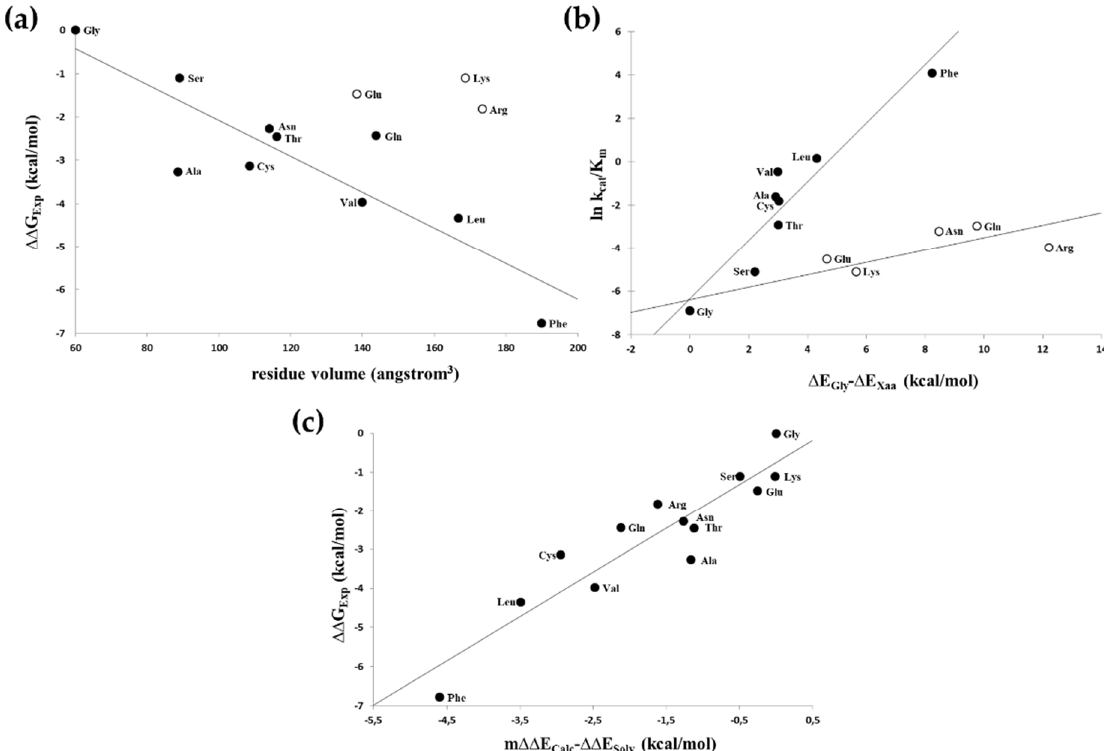
Figure 3. Plotting experimentally determined relative activation energies and calculated S1 (cid:48) -P1 (cid:48) relative interaction energies. ( a ) Volumes of non-charged P1 (cid:48) residues (solid circles) correlated well (r 2 = 0.76) with the experimentally determined relative activation energies, while charged P1 (cid:48) residues (open circles) were kinetically substantially less favourable than non-charged residues having similar sizes and were excluded from the correlation. ( b ) Interaction energies calculated for nonpolar (solid circles) and polar/charged (open circles) residues gave separate correlations with the specificity constants (r 2 = 0.88 and r 2 = 0.73, respectively). ( c ) Correlation of calculated S1 (cid:48) -P1 (cid:48) relative interaction energies corrected for the solvation energy with the experimentally determined relative activation energies. Calculated relative interaction energies were multiplied by an empirical value (m = 0.25) and corrected with the relative solvation energies as described in the text gave a good correlation (r 2 = 0.85) with the relative activation